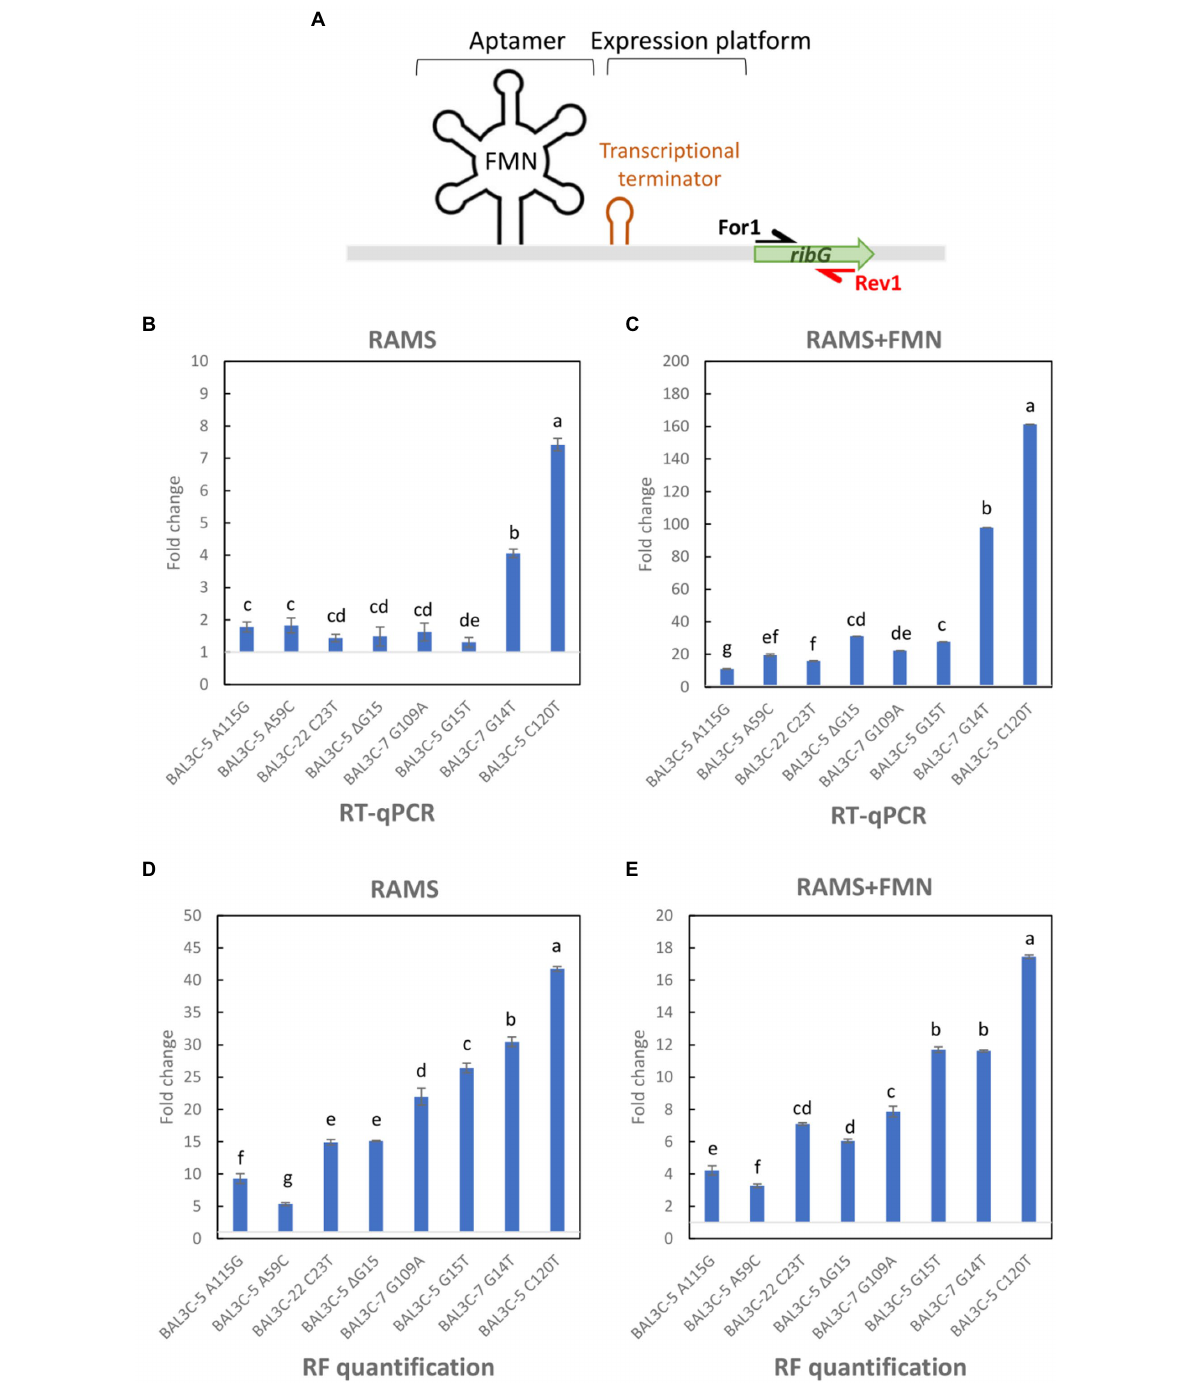
( p ≤ 0.05). The fold change values varied from 1.30 to 7.42 for mutant strains grown in RAMS (Figure 7B). In this case, BAL3C-5 C120T mutant strain showed the highest transcription level. A more